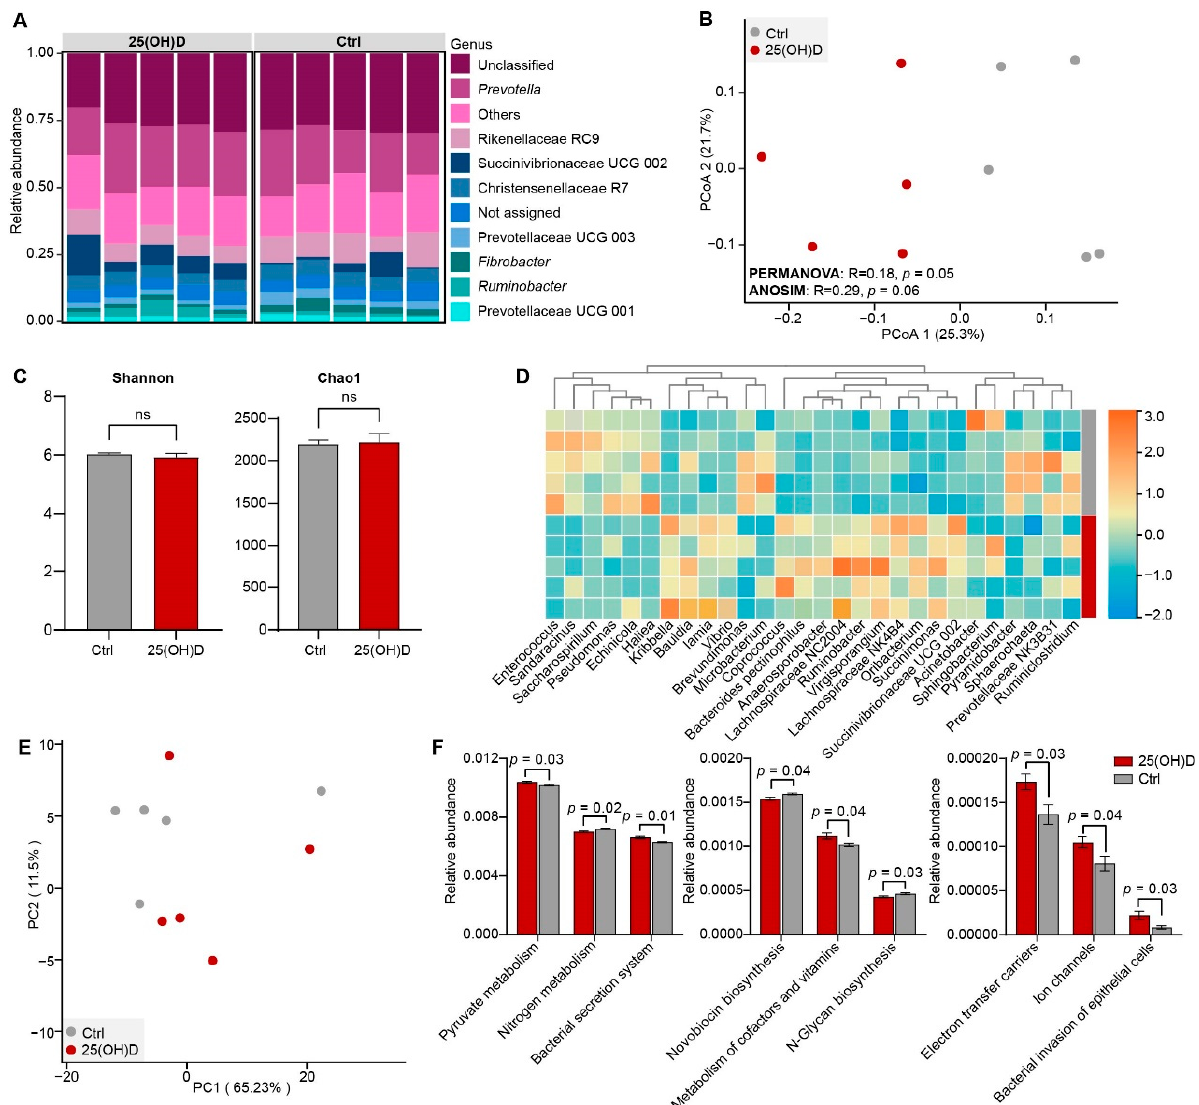
Figure 3. Rumen bacterial community and the predicted functional profiles. ( A ) Bacterial composi- tion in the rumen fluid of sika deer between the Ctrl and 25(OH)D groups at the genus level. ( B ) Comparison of the alpha diversity indices in the rumen fluid of sika deer between the Ctrl and 25(OH)D groups. ns means no significant differences. ( C ) PCoA results showing the separation of the rumen bacteria between Ctrl and 25(OH)D groups at the OTU level based on the Bray–Curits dissimilarity matrix. ( D ) Heatmap showing the significantly changed bacteria genera in the rumen liquid between the Ctrl and 25(OH)D groups. Square colors indicate the normalized relative abun- dance of each genera from the minimum (blue) to maximum (orange). Rumen liquid samples from the Ctrl group and 25(OH)D group were indicated by grey and red bars on the right side of the heatmap, respectively. ( E ) PCA revealing the difference in the bacterial functional profiles at KEGG level 3 (relative abundance) based on the Euclidean metric. ( F ) Histograms showing the significantly changed pathways at KEGG level 3.